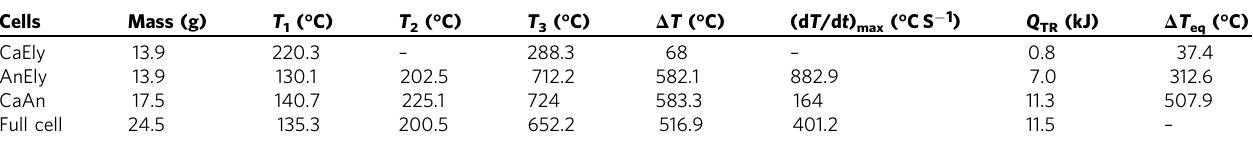
Table 1 Thermal runaway features of the partial cells and full